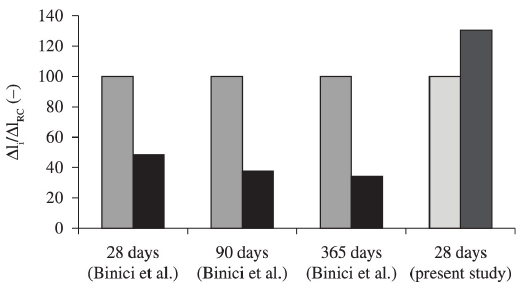
Figure 12. Abrasion wear loss relative to the RC: Binici et al. 6 vs. present